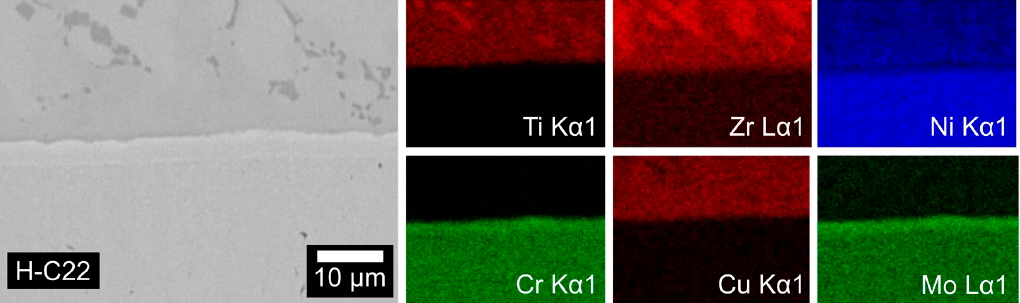
Figure 5. SEM image of the Hastelloy C22 ® /BTi-5 interface and the related element maps after the wettability test at 900 °C for 5 min.